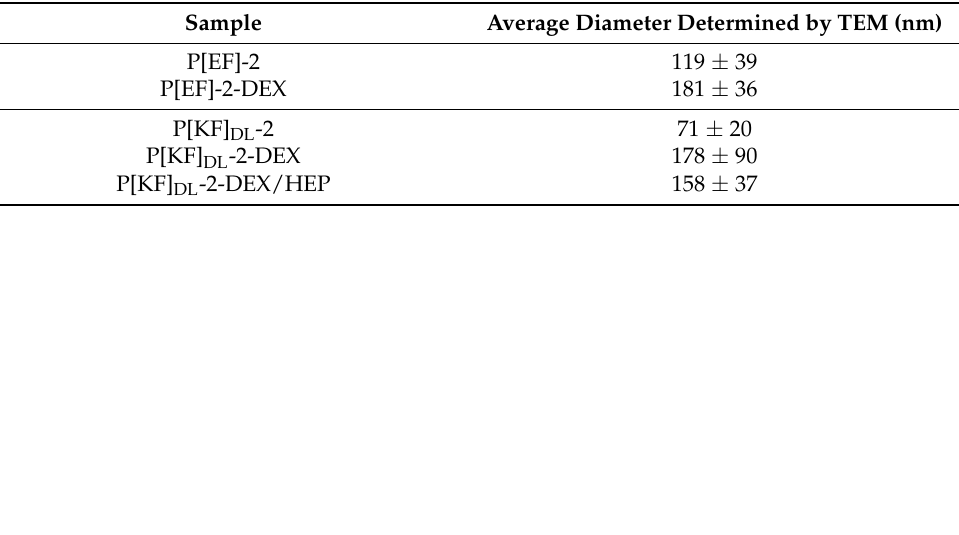
Figure 8. Dependence of DEX-content conjugated to the polypeptide (P[KF] D,L -1) on the amount of DEX-S taken for conjugation.